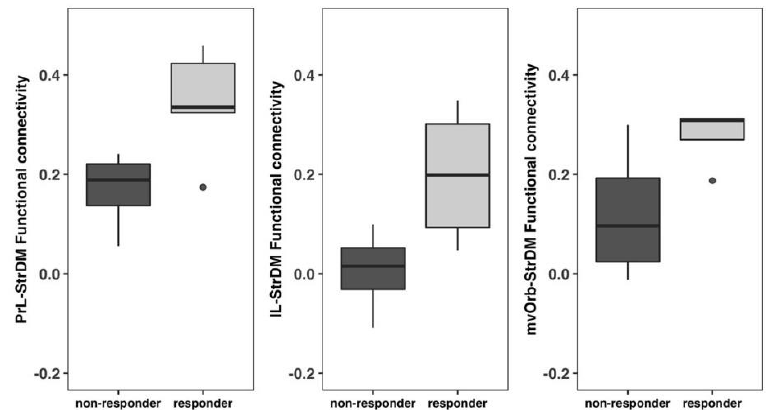
Figure 9. Functional connectivity differences between responders and non-responders in ethanol exposed male rats. Responders had significantly higher Prelimbic Cortex to dorsomedial Striatum (PrL-StrDM) and infralimbic to dorsomedial Striatum (IL-StrDM) functional connectivity compared to non-responders. Increased medial-ventral Orbitofronal cortext-dorsomedial Striatum (mvOrb-StrDM) functional connectivity in responders compared to non-responders was also detected. The dots represent animals outside 1.5 times the interquartile